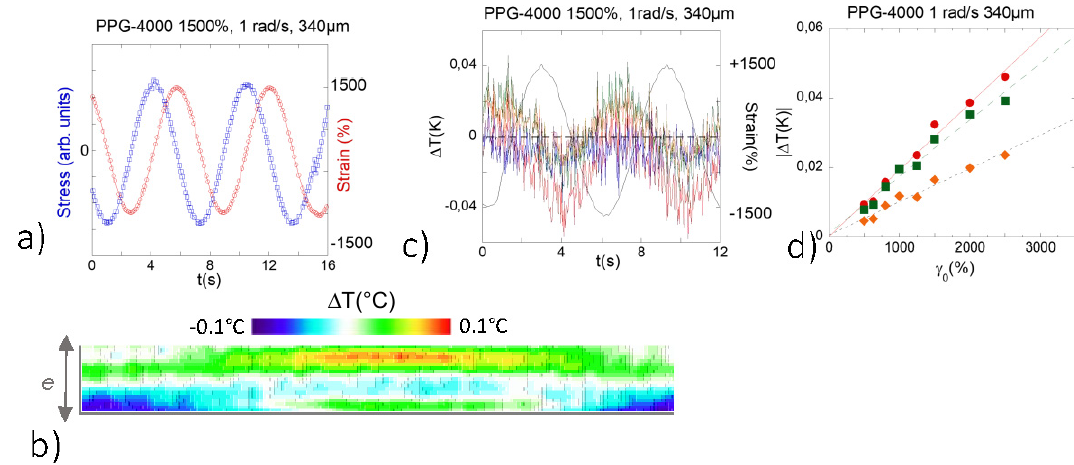
Figure 3. PPG-4000: ( a ) Stress–strain curves for the PPG ( a ) at 340 µ m, ω = 1 rad/s, and 1500% (measured simultaneously to the thermal measurements; the upper plane was fixed while the bottom one oscillated). ( b ) Thermal mapping of the gap filled with PPG-4000 recorded along one oscillatory period ( ω = 1 rad/s, γ = 1500%, and e = 340 µ m gap thickness, room temperature measurements carried out on alumina plates, the upper plane was fixed while the bottom one oscillated). ( c ) Details of the temperature oscillation: cold band ( (cid:4) ), the hot band ( • ) and bulk value ( (cid:7) ), black line: strain wave ( ω = 1 rad/s, γ = 1500%, and e = 340 µ m gap thickness)). ( d ) Strain dependence of the temperature variation (absolute value | ∆ T | = T − T γ =0 ) at 1 rad/s and e = 340 µ m: cold band ( (cid:4) ), the hot band ( • ), and bulk value ( (cid:7) ) highlighting the linear dependence of the temperature variation to the strain amplitude. The bands are centered on the highest, the lowest and the medium temperature zones.